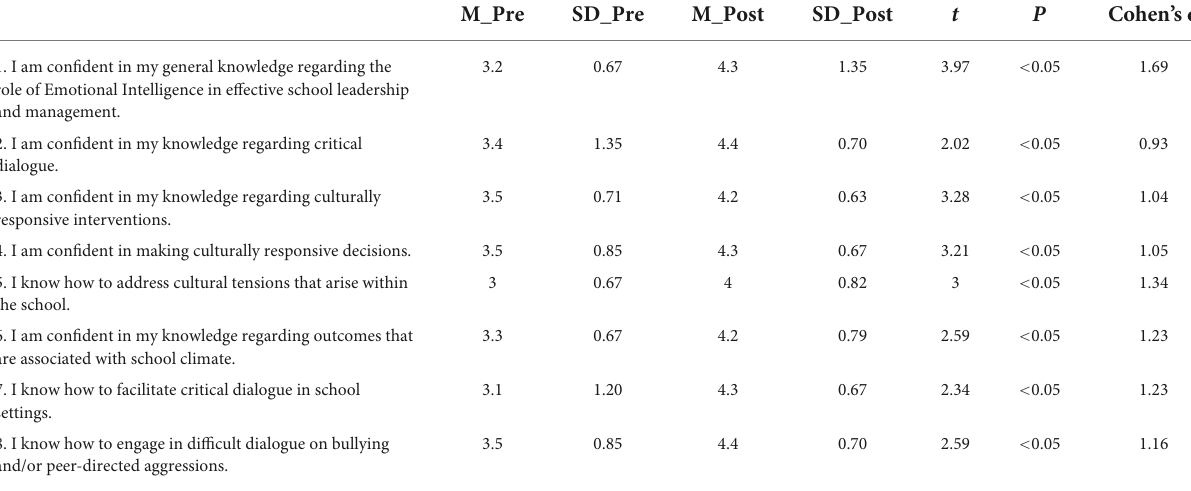
TABLE 2 Participants’ perceptions of the effectiveness of the VPD related to conflict